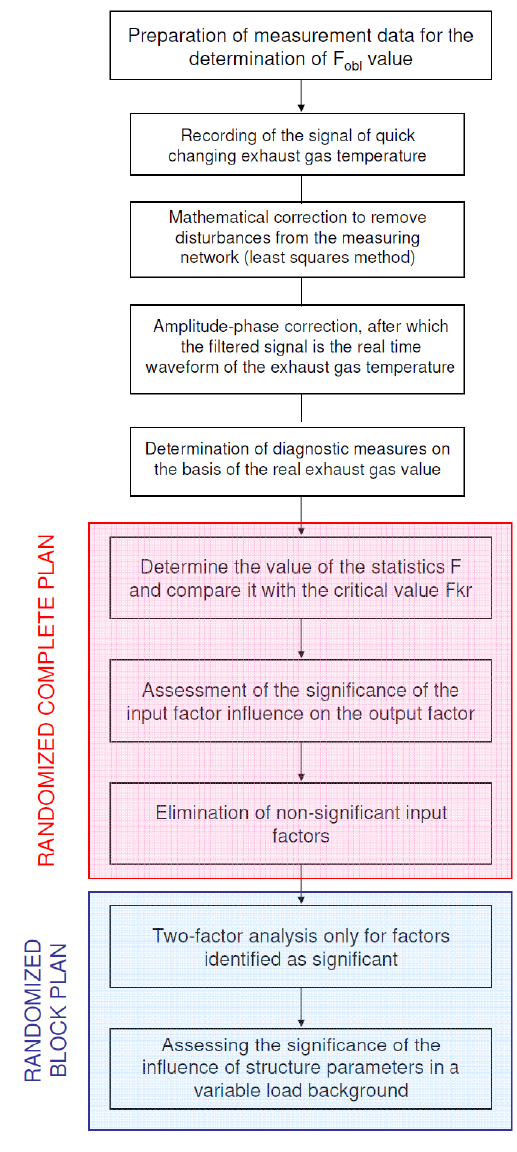
Fig. 5. Steps in determining the F-statistic of the Fisher-Snedecor distribu- tion for diagnostic